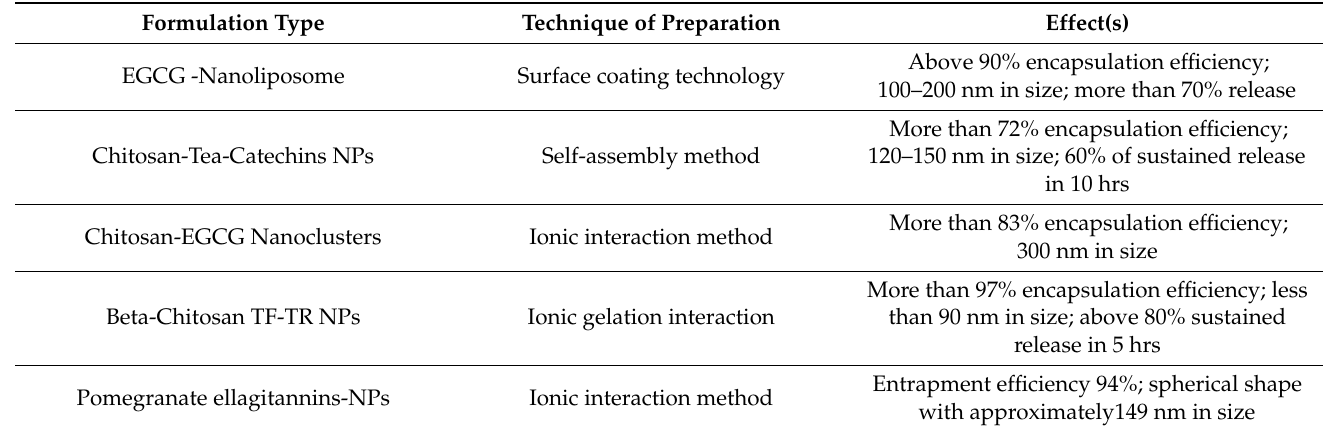
Table 2. Formulation paradigms designed to enhance physicochemical properties of polyphenols in